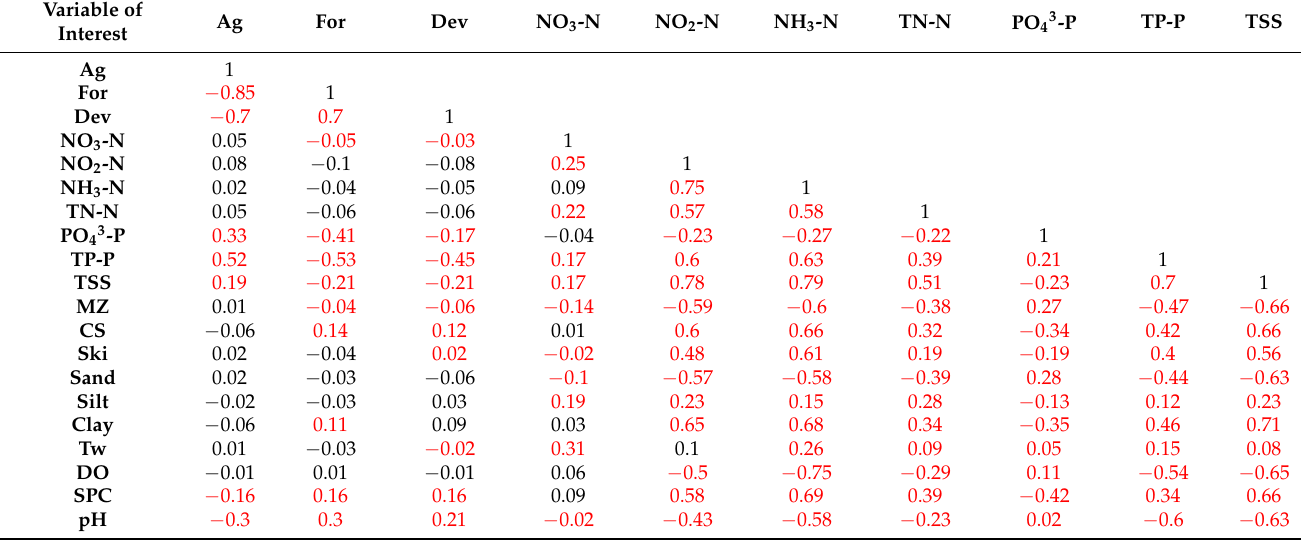
Table A4. Spearman’s correlation results, including land use percent [Agriculture (Ag;%), Forest (For,%), and Developed (Dev,%)], nutrient concentrations (mg L − 1 ), suspended sediment characteris- tics [total suspended solids; TSS (mg L − 1 ), mean particle size; MZ ( µ m), calculated surface area; CS (m 2 mL − 1 ), skewness; Ski, Sand (%), Silt (%), and Clay (%)], and physicochemical variables [water temperature (Tw; ◦ C), dissolved oxygen (DO;% saturation), specific conductance (SPC; µ s cm − 1 ), and pH] of surface water and shallow groundwater during the study period (January 2020–December 2021) for eight monitoring sites in Moore’s Run, Watershed, WV, USA. Note: red text indicates significant correlations ( p < 0.05). The second portion of the table is a continuance from the preceding.